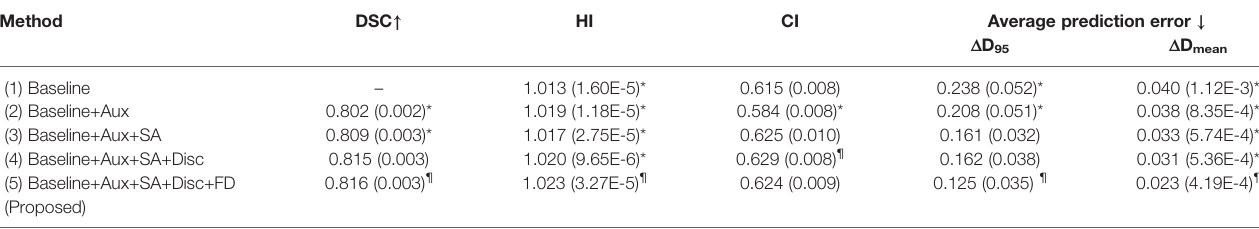
TABLE 3 | Ablation studies of our propose method with its